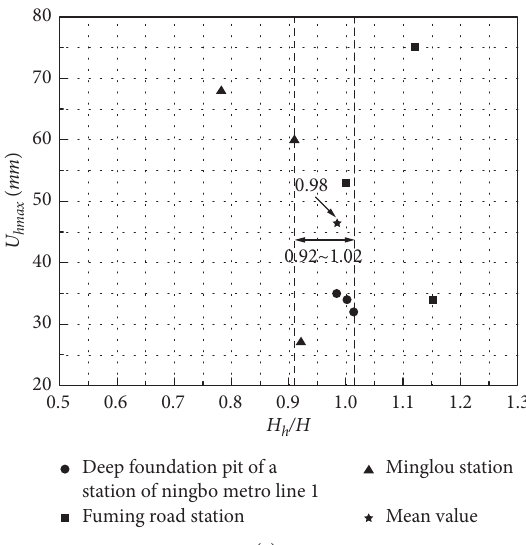
Figure 3: Relationship between the maximum lateral deformation and the relative depth of the maximum lateral deformation of the diaphragm wall. (a) Hangzhou. (b) Shanghai. (c)